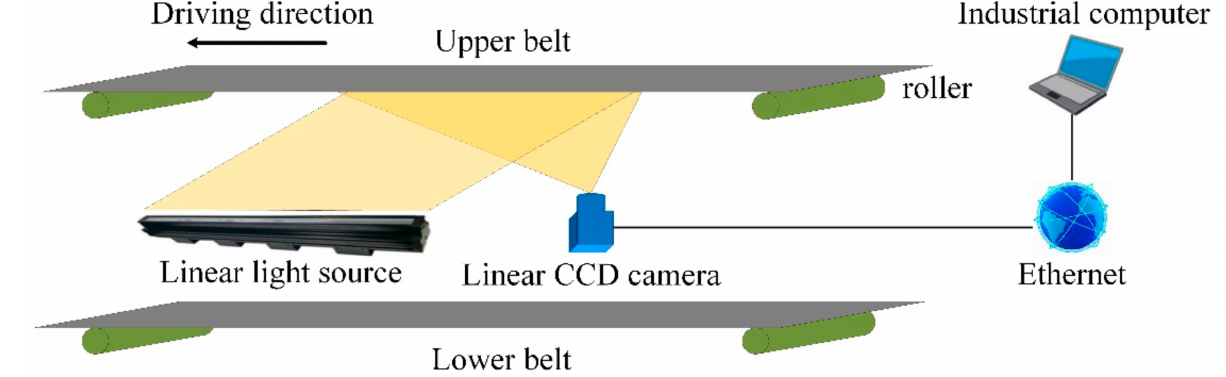
Figure 6. Sketch of underground image acquisition